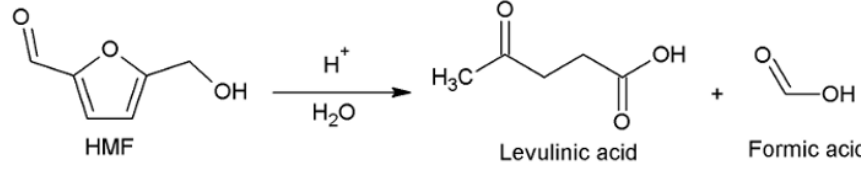
Figure 4. Rehydration of HMF to levulinic and formic acids.